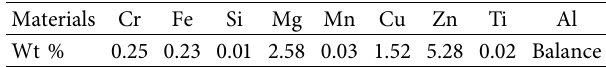
Table 2: Chemical constituents of aluminium alloy (AA7075) [25]. Materials